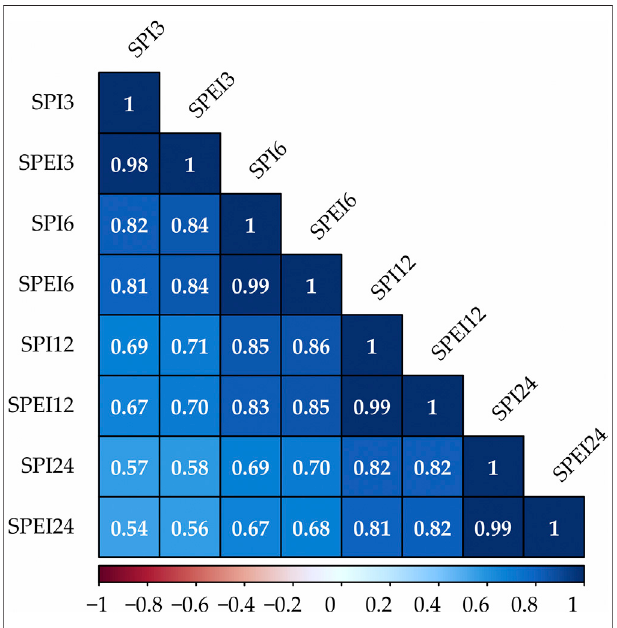
FIGURE 8 | Correlation between SPI and SPEI indices at different time scales. All correlations are statistically signi fi cant at p <